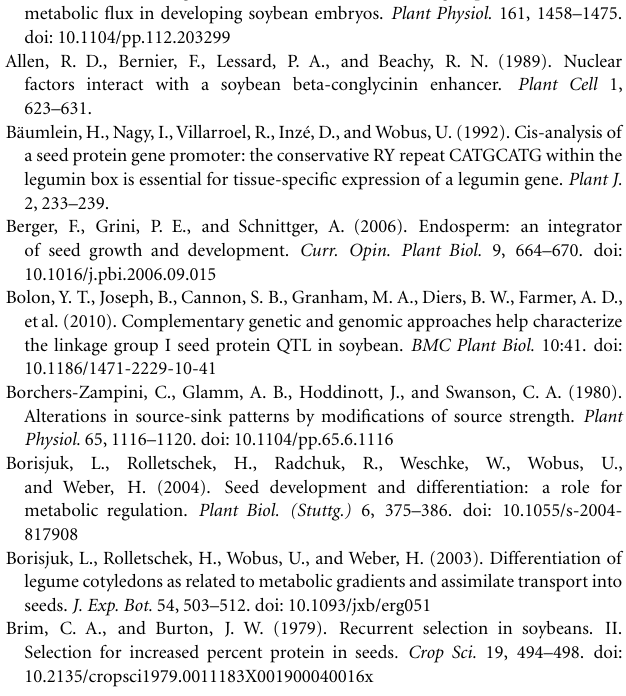
FIGURE 3 |A comparison of the expression of the storage protein trait in somatic embryos and seeds is shown as a GFP-HDEL glycinin mimic allele expressed as a storage protein proxy. The somatic embryo in white light (A) and UV fluorescence (B) shows that the primary GFP expression site is in the cotyledon that is reduced in size compared to cotyledons of seed. In seeds the cotyledons comprise the large majority of the seed’s mass shown